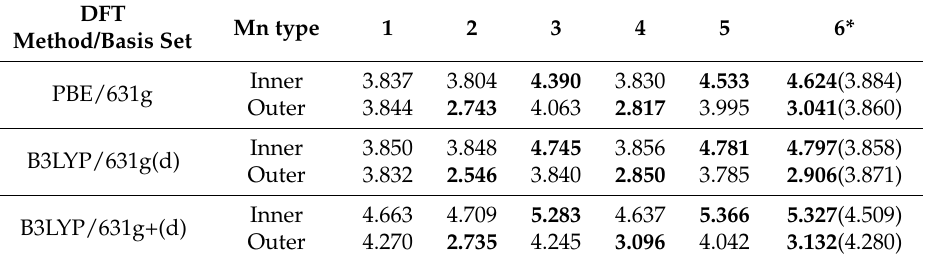
Table 7. Mulliken spin populations of Mn atoms in the models considered